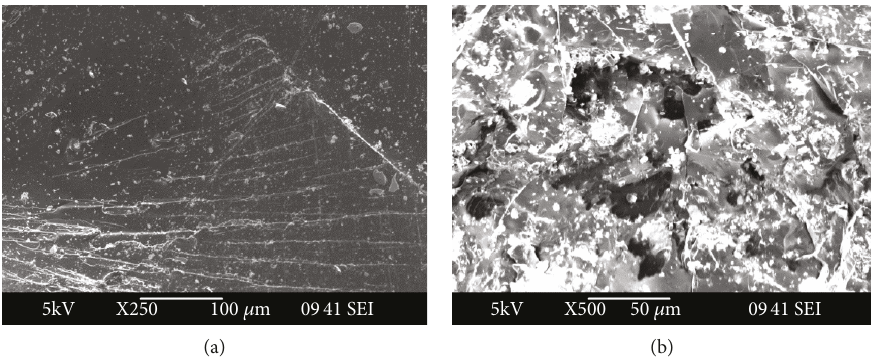
Figure 5: (a) SEM images showing the relatively pore-free “ solid ” surface; (b) coal with a fi lled pore structure.